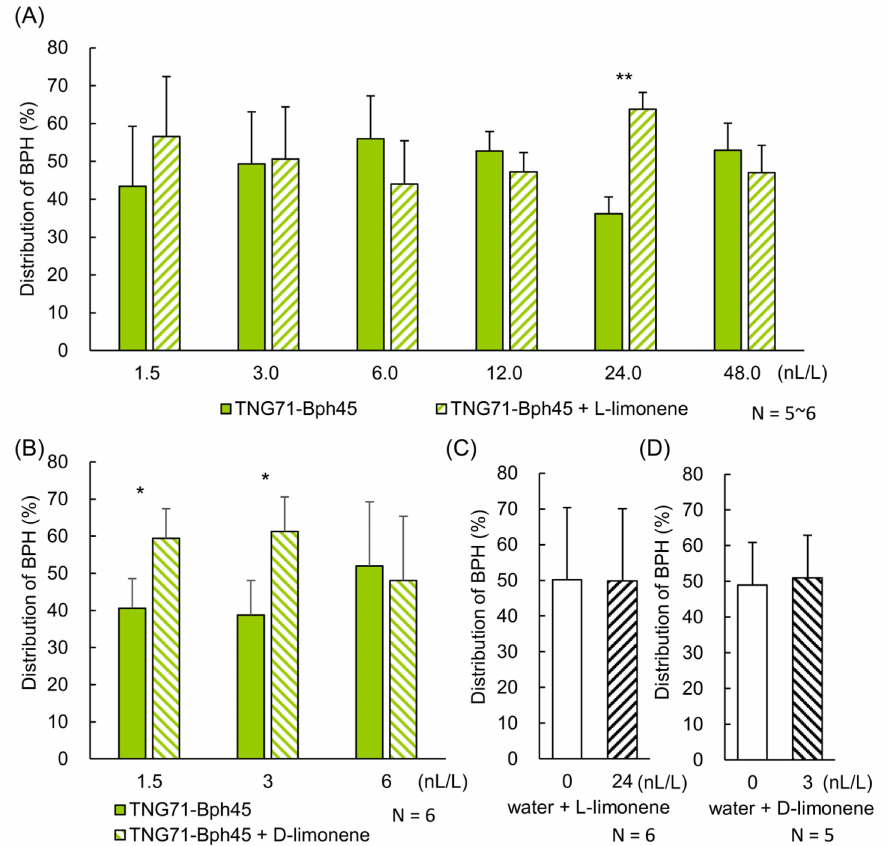
Figure 5. The attractiveness of limonene to BPH in Y-maze tests. BPHs were released in a Y- maze tube with air supplied through containers containing various amounts of ( A ) L-limonene or ( B ) D-limonene in the presence of TNG71- Bph45 rice. ( C , D ), same as ( A , B ), respectively, but limonene alone was used. The percentage of BPHs that moved to each side of the trap was calculated 2 days after release. Results of independent replicates (as indicated) were analyzed using Student’s paired t -test. * p < 0.05 and ** p <